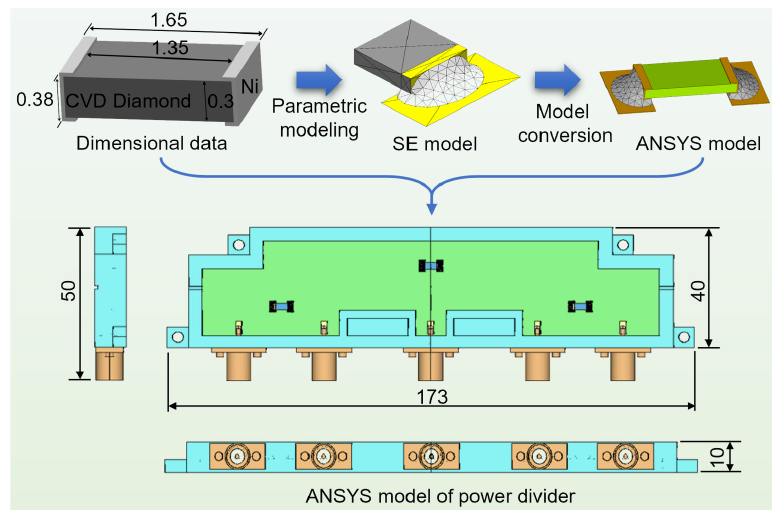
Figure 1. Schematic process of numerical simulation.